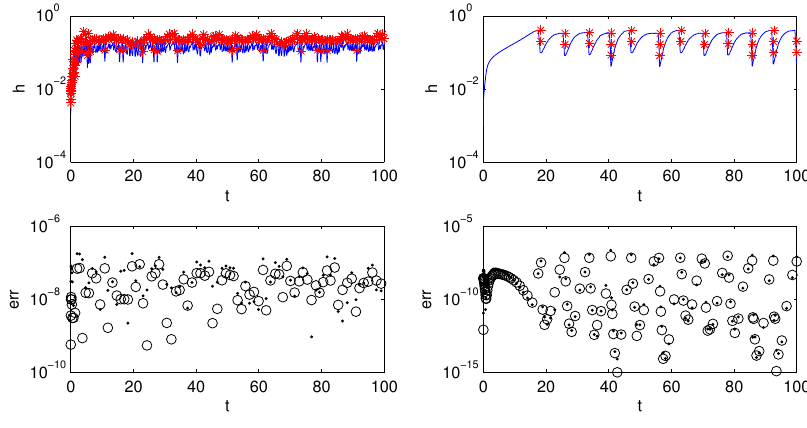
Figure 2. Results of method of order p = 4 with tolerance tol = 10 − 6 on problem (4.2). Top: Rejected steps (*) and stepsize pattern (solid line); bottom error estimations ( · ) vs local error ( ◦ ). Left: standard step changing strategy, right: PI controller. Error figures - every 5-th